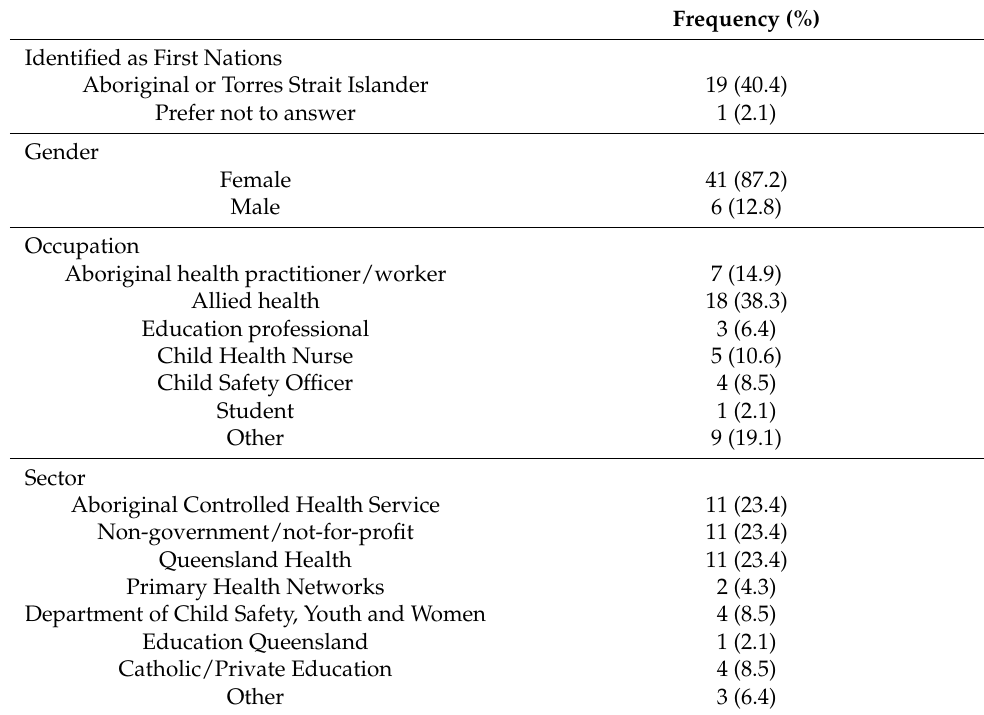
Table 1. Workshop attendee demographics ( n =